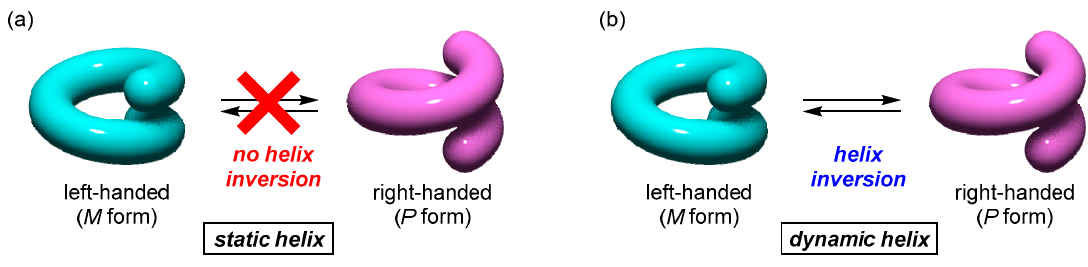
Figure 1. The P and M forms of ( a ) static and ( b ) dynamic helical structures.